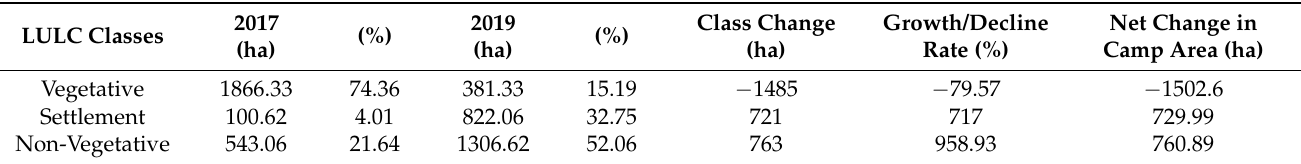
Table 5. Area and spatial changes in land cover classes and overall net gain and losses between 2017 and 2019 among the thirty-four Rohingya refugee camp areas.